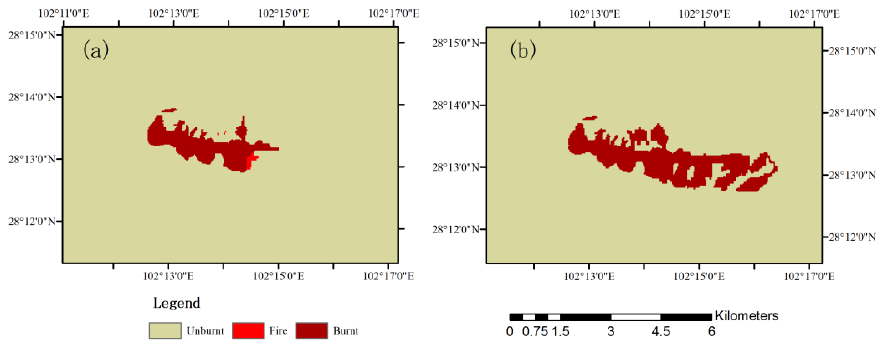
Figure 5. Extracted fire situation map: ( a ) initial and ( b ) ultimate. The DEM was also used to extract terrain information, such as slope and